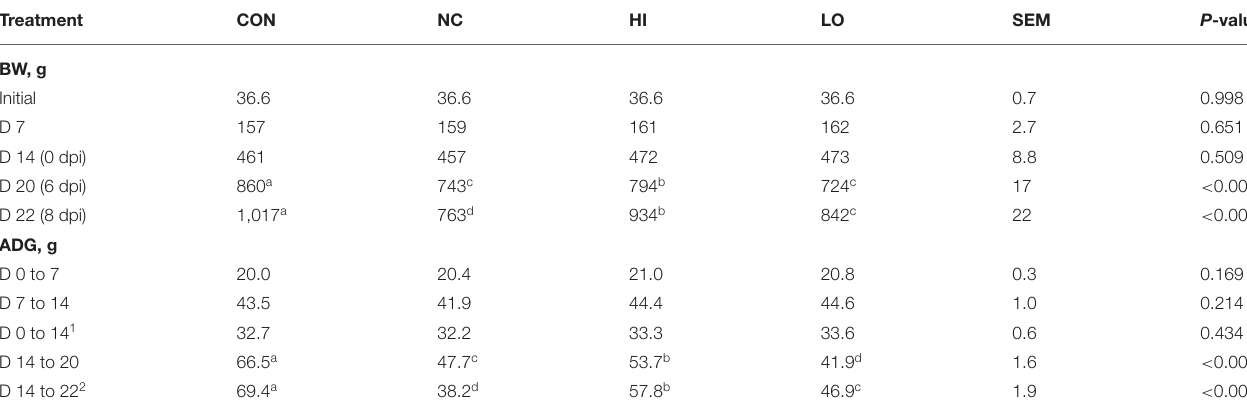
TABLE 3 | Body weight and average daily gain chickens fed a diet supplemented with maltol. Treatment CON NC HI LO SEM P -value